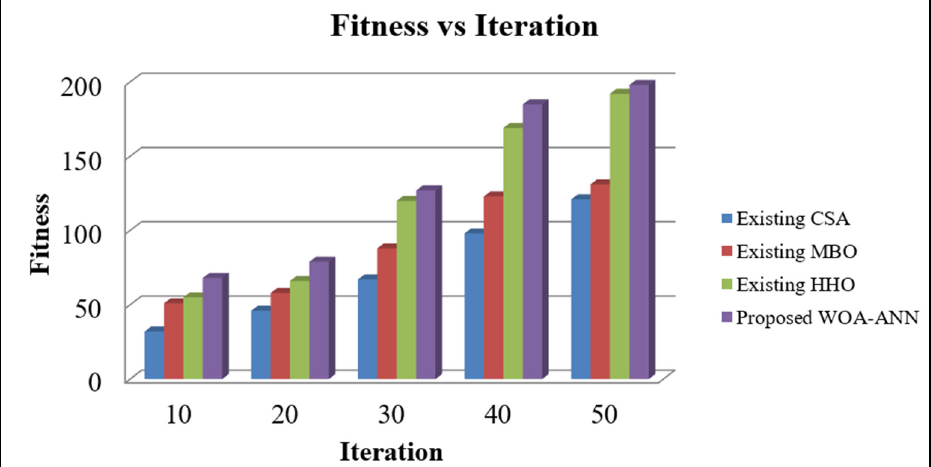
Figure 11. Fitness vs. iteration for proposed sequential WOA-ANN.